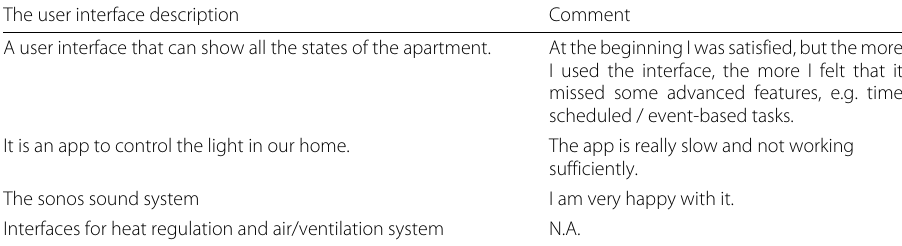
Table 5 Smart home user interfaces that had been used by the participants before the test and their comments on the user